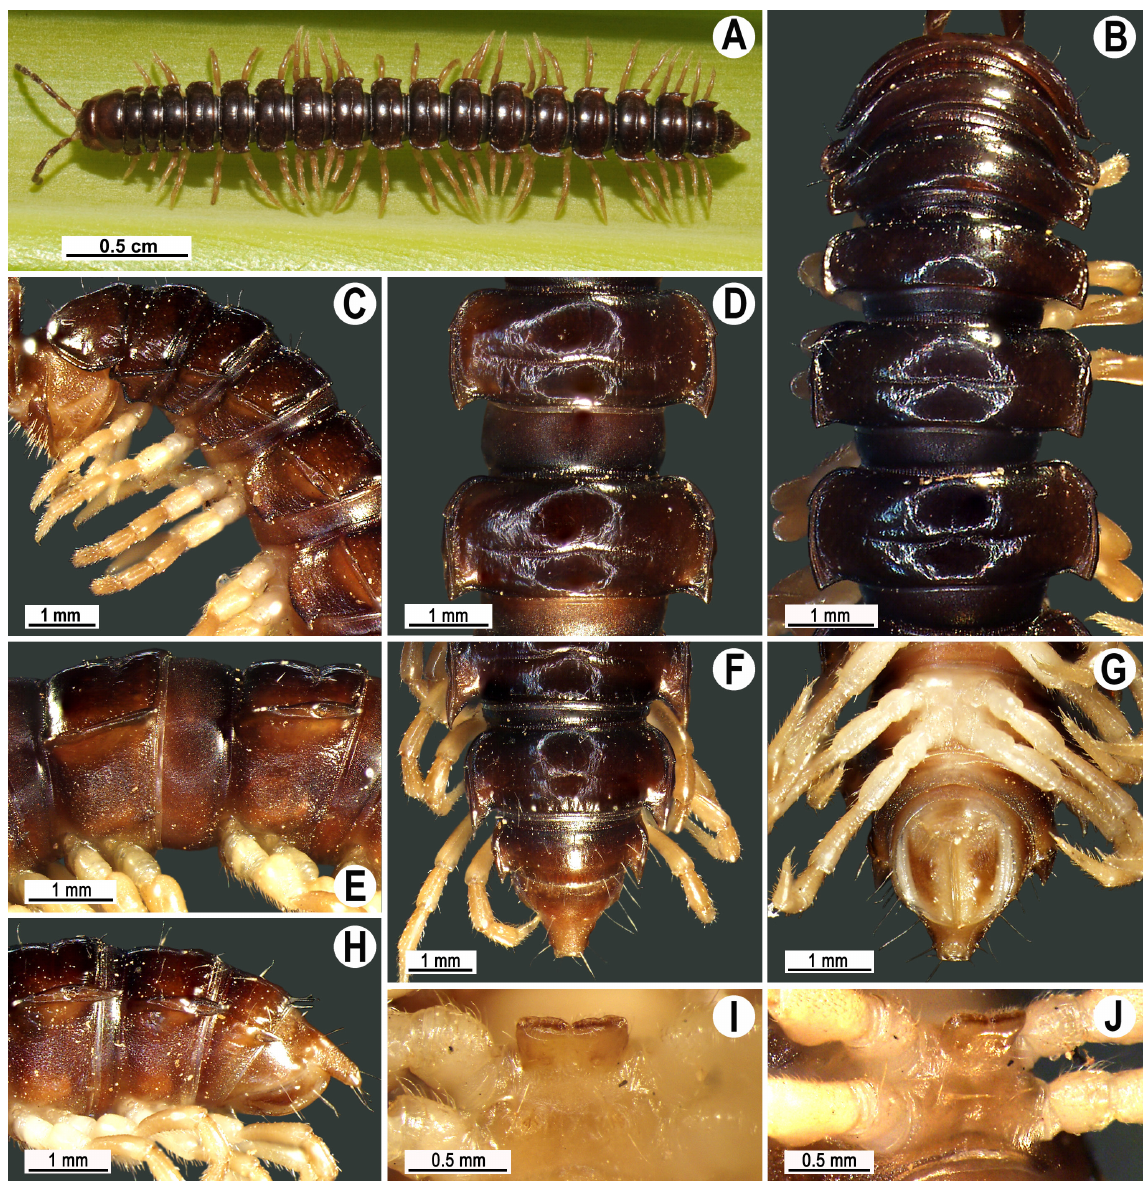
Fig. 12. Tylopus acuminatus sp. nov., holotype, ♂. A . habitus, live coloration. B–C . anterior part of body, dorsal and lateral views, respectively. D–E . Segments 10 and 11, dorsal and lateral views, respectively. F–H . Posterior part of body, dorsal, ventral and lateral views, respectively. I–J . Sternal cones between coxae 4, caudal and sublateral views,